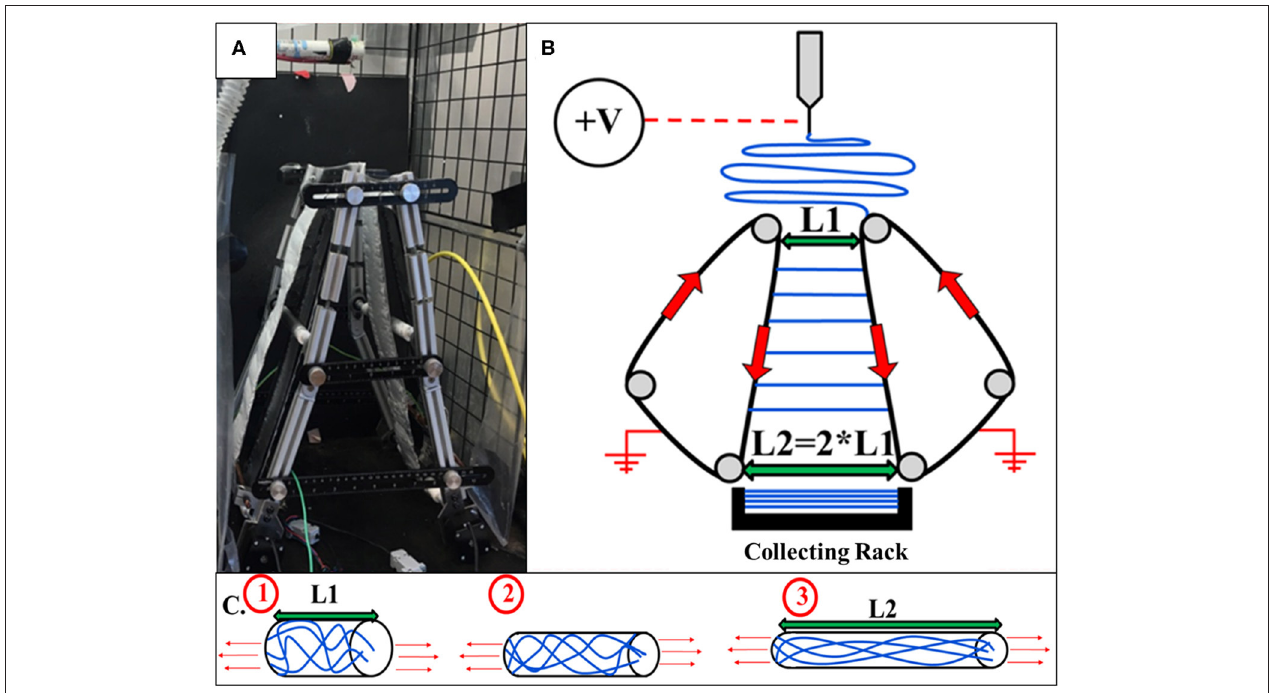
FIGURE 1 | (A) Automated adjustable track system capable and collecting and post-drawing thousands of electrospun nanofibers individually. (B) A diagram illustrating the collection and extension of electrospun nanofibers using the revolving automated tracks. (C) A representation of the macromolecular structure of a polymer chain at the top of the automated tracks (1), in the middle of the tracks (2), and at the bottom of the tracks as well as in the collecting rack